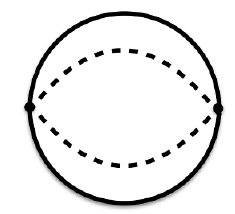
Figure 2 . Three-loop